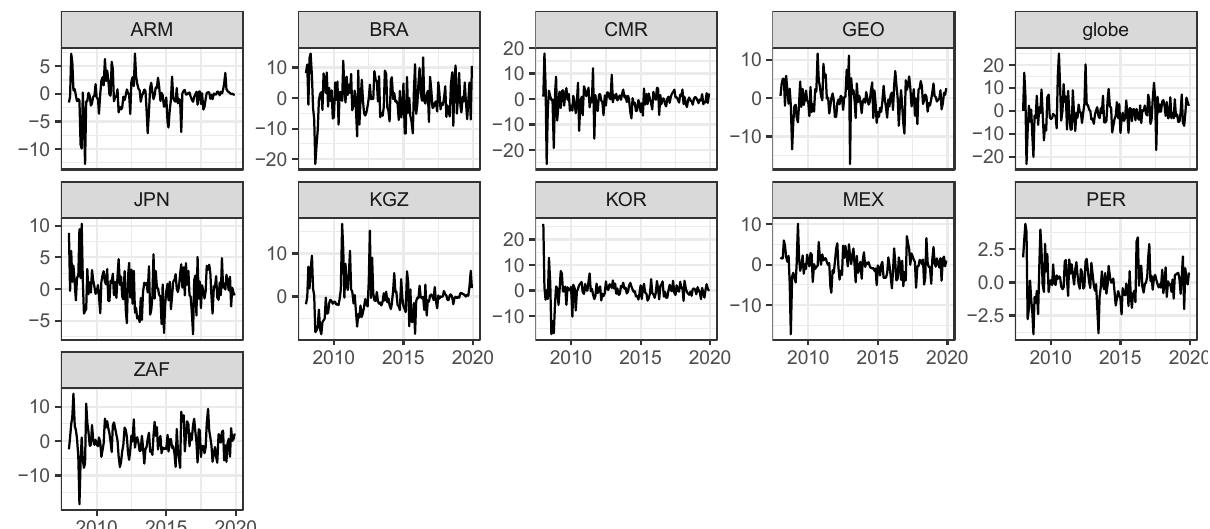
Figure 1. The movements in global and local wheat prices returns. ARM, BRA, CMR, GEO, globe, JPN, KGZ, KOR, MEX, PER, and ZAF stand for Armenia, Brazil, Cameroon, Georgia, global, Japan, Kirgizstan, South Korea, Mexico, Peru, and South Africa, respectively.